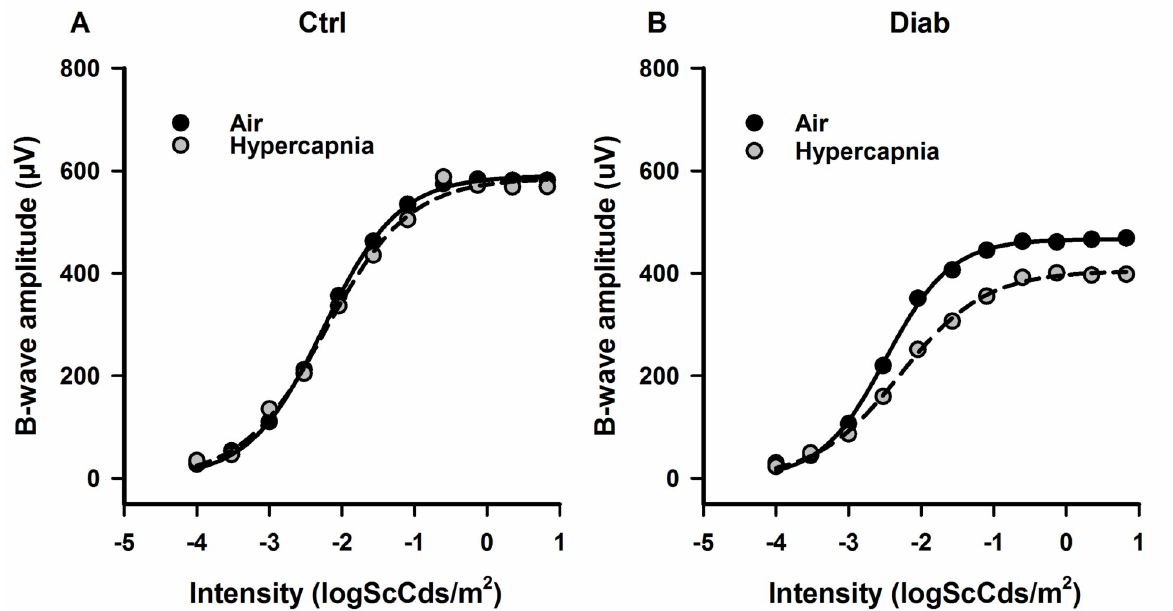
Fig 2. Examples of ERG intensity-response series for b-wave amplitudes fit with a Naka-Rushton function from a Ctrl mouse (A) and Diab mouse (B) under regular room air condition (black circles with solid line fit) and under hypercapnia (gray circles with dashed line fit). (Group means are provided in Table